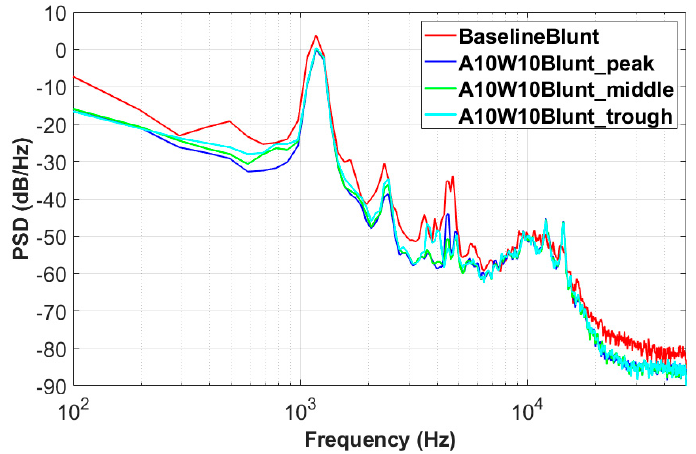
Figure 14. PSD of the pressure fluctuations at 0.98 c on each airfoil surface.